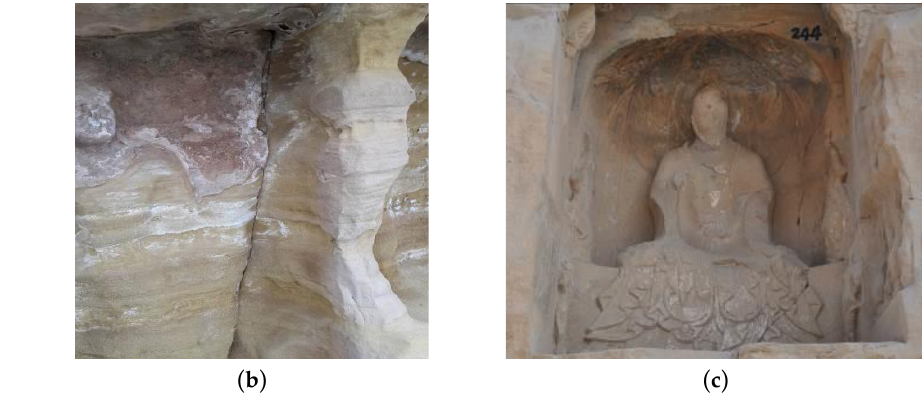
Figure 8. Weathering characteristics of Qingyang North Grottoes under freeze–thaw action. ( a ) Significant fissures at the base and upper areas of the cave; ( b ) white crystal precipitation from the upper and middle surfaces of the cavity; ( c ) the blurred face of the Buddha.